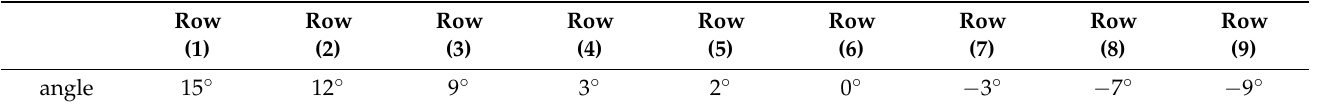
Figure 3. Closer look at uneven curved shape of Toyota Prius roof. Table 1. Longitudinal angles of PV cells on the roof of a Toyota